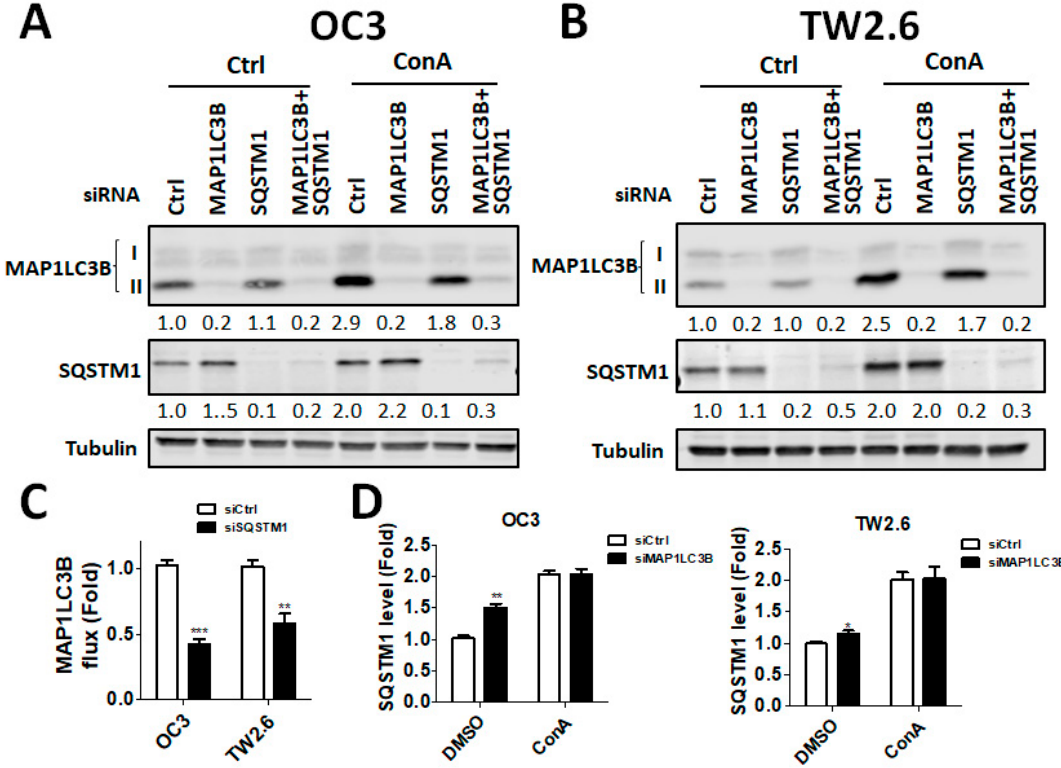
Figure 6. Effects of silencing MAP1LC3B and SQSTM1 on autophagy and cell proliferation in BMSCC cells. ( A ) The BMSCC cell lines OC3 and ( B ) TW2.6 were transfected with 5 nM scrambled siRNA or siRNA against MAP1LC3B or SQSTM1 for 48 h and then were treated with ConA for 4 h. The knockdown efficiency was determined by immunoblotting. ( C ) Silencing effects on MAP1LC3B flux and ( D ) SQSTM1 levels were quantified and analyzed.